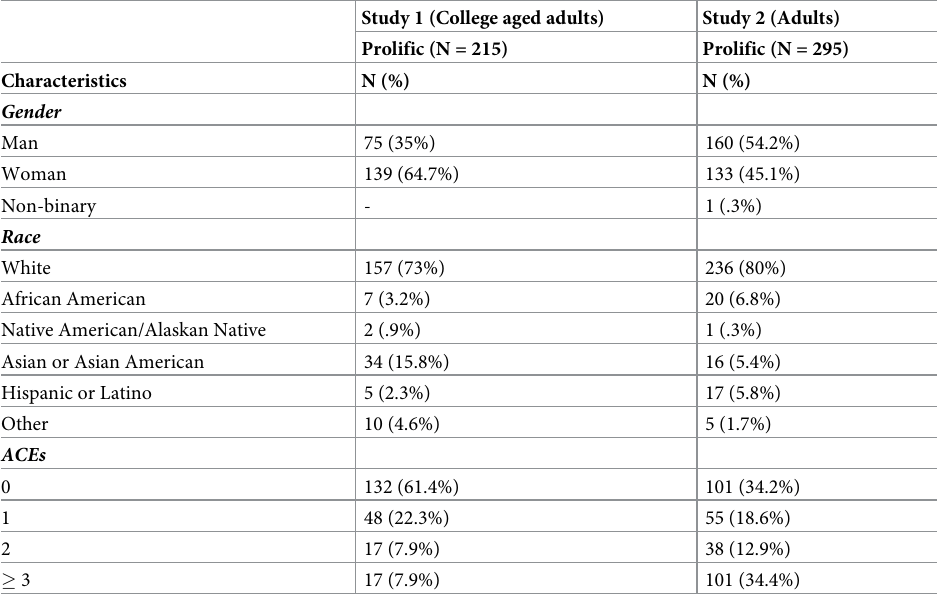
Table 1. Demographic characteristics and descriptive